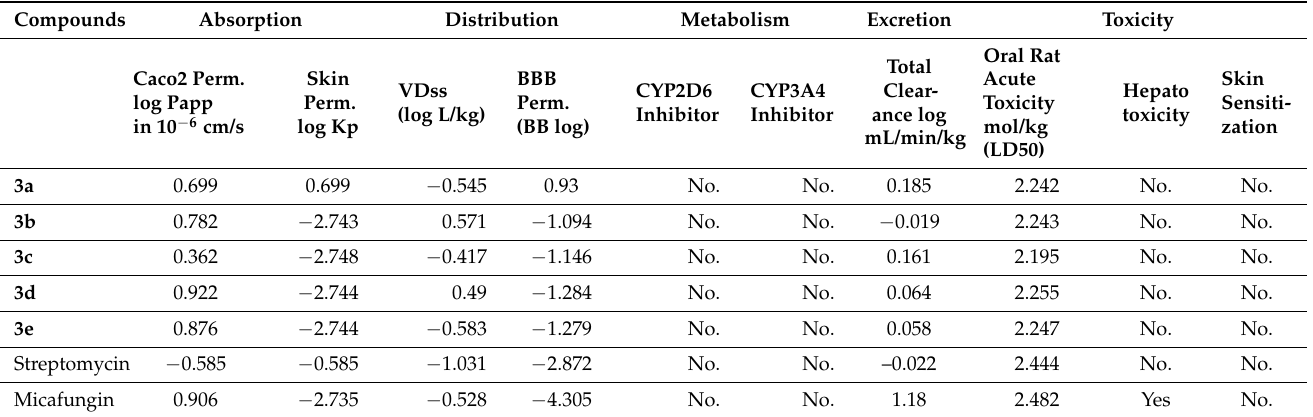
Table 1. The result of ADMET